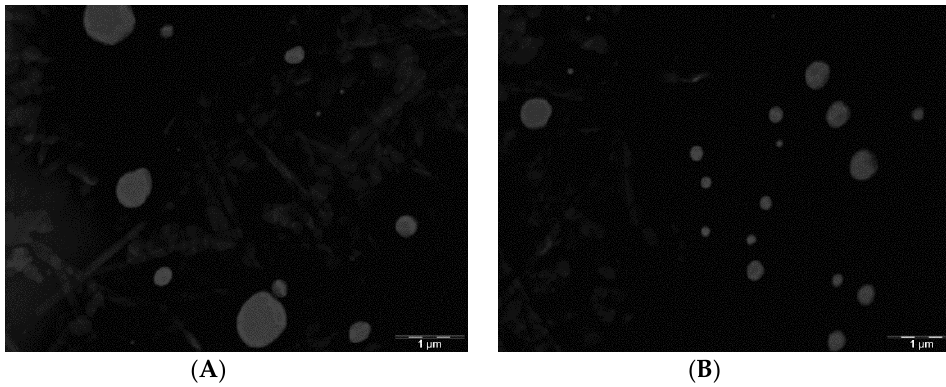
Figure 1. Transmission Electron Microscopy image of NLCs F3-L ( A ) and NLC F9-L ( B ).